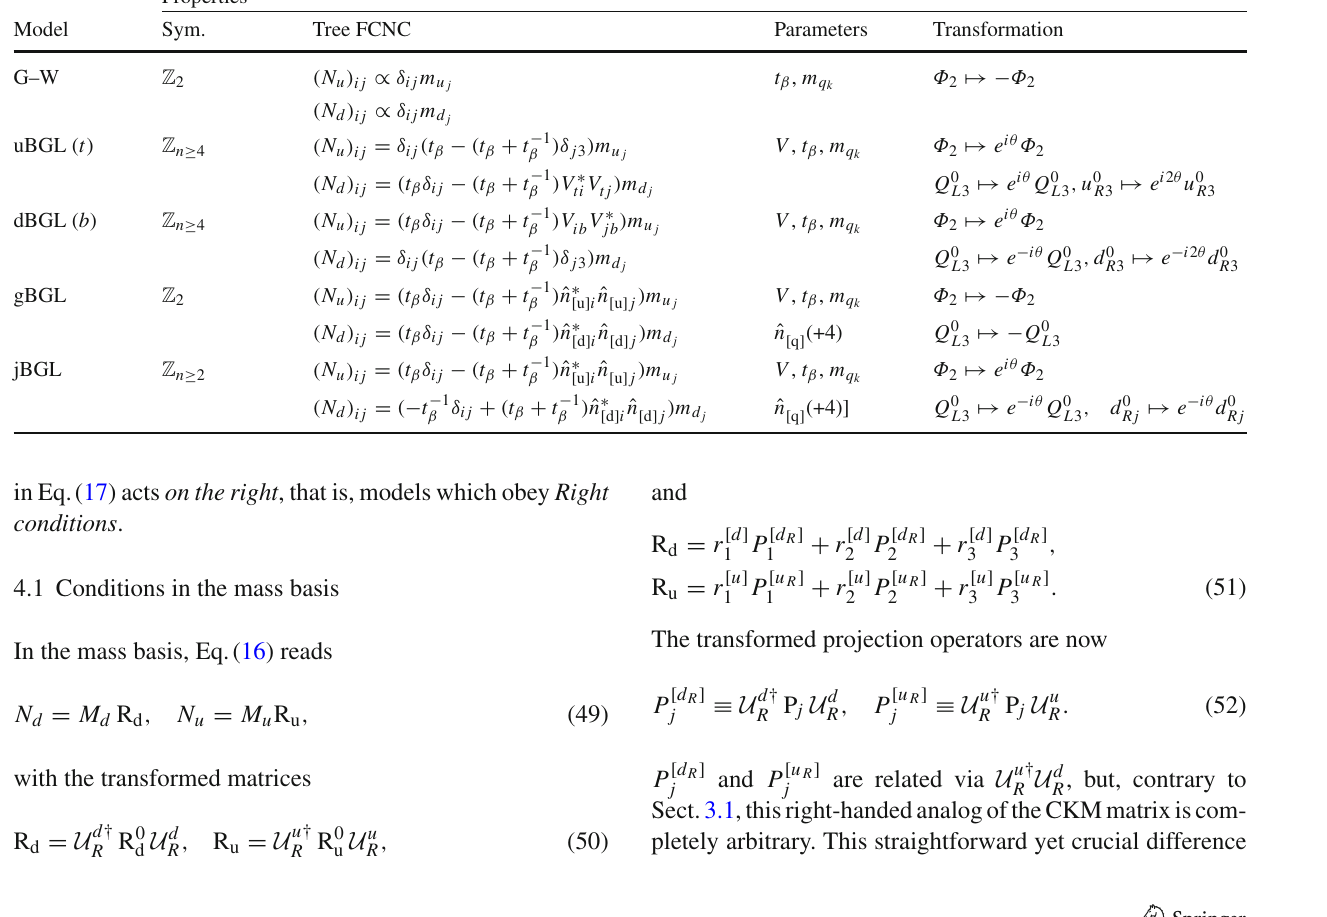
Glashow–Weinberg models without tree level FCNC for comparison. In the “Parameters” column, (+4) is the number of new real parameters corresponding to ˆ n [ q